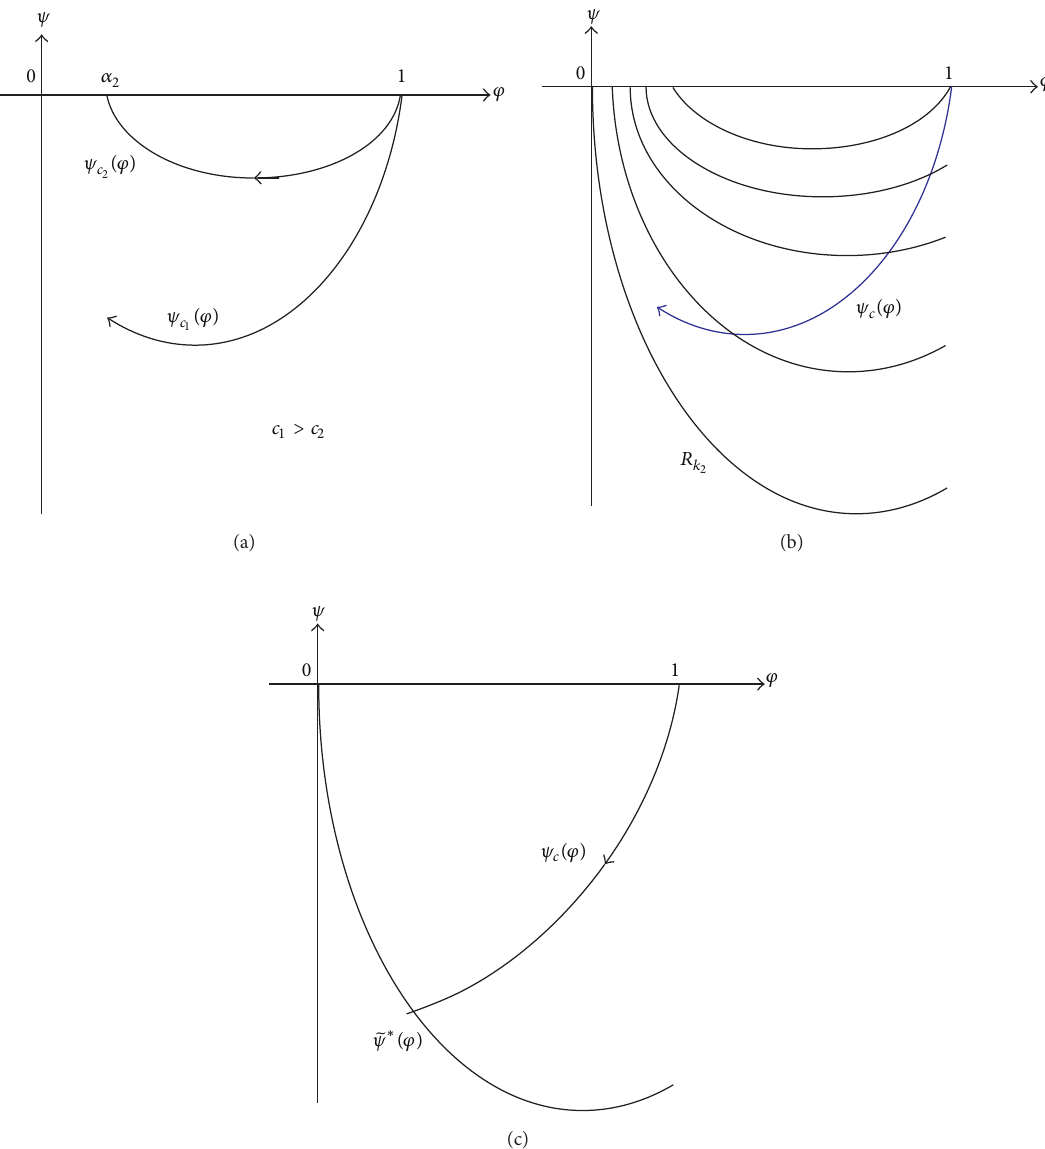
Figure 4: The properties of the trajectory 𝜓 𝑐 (𝜑) . (a) The monotonicity of 𝜓 𝑐 (𝜑) on 𝑐 . (b) The trajectory 𝜓 𝑐 (𝜑) wanders through 𝑅 𝑘 . (c) The trajectory 𝜓 𝑐 (𝜑) intersects with ̃𝜓 ∗ (𝜑) for large 𝑐